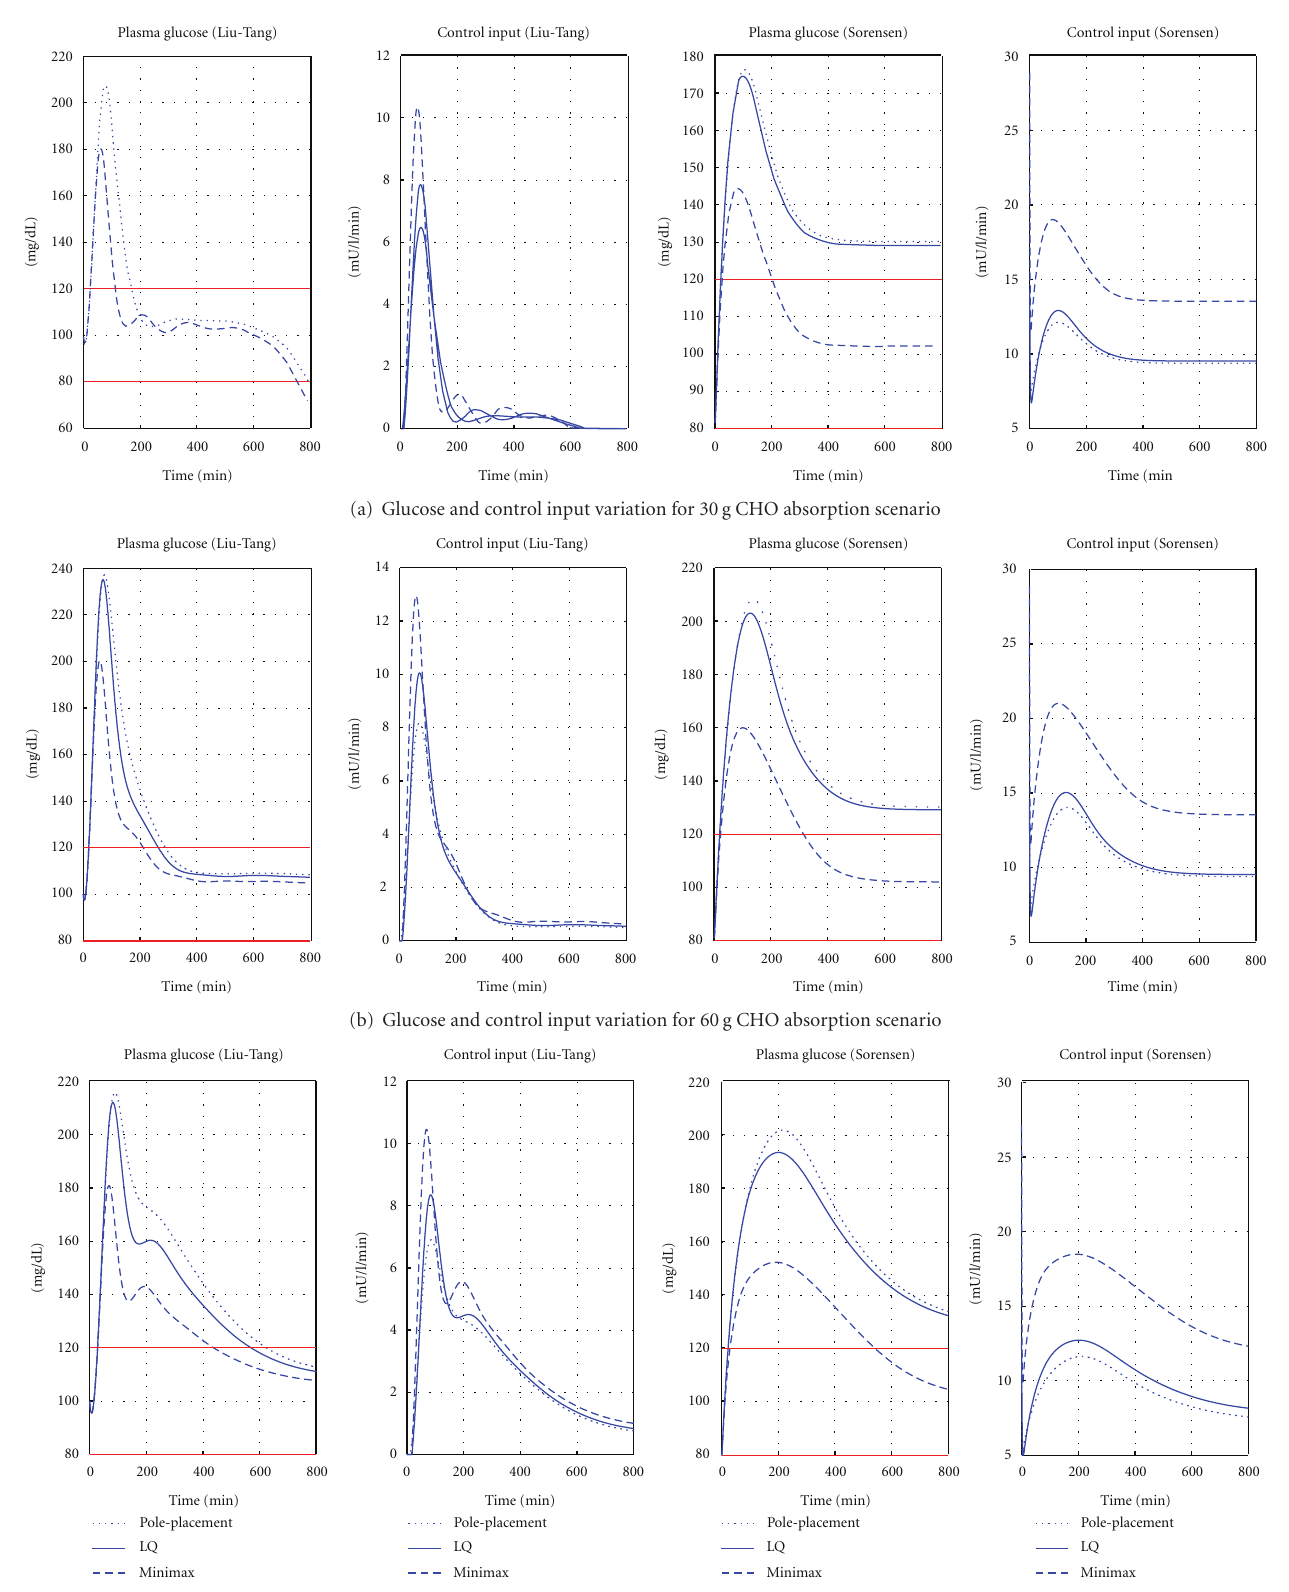
MinimaxLQPole-placement (c) Glucose and control input variation for 100g CHO absorption scenario Figure 9: Comparison of pole-placement, LQ, and minimax control methods on the modified Liu-Tang model and modified Sorensen- model for the three dynamic absorption scenarios taken into